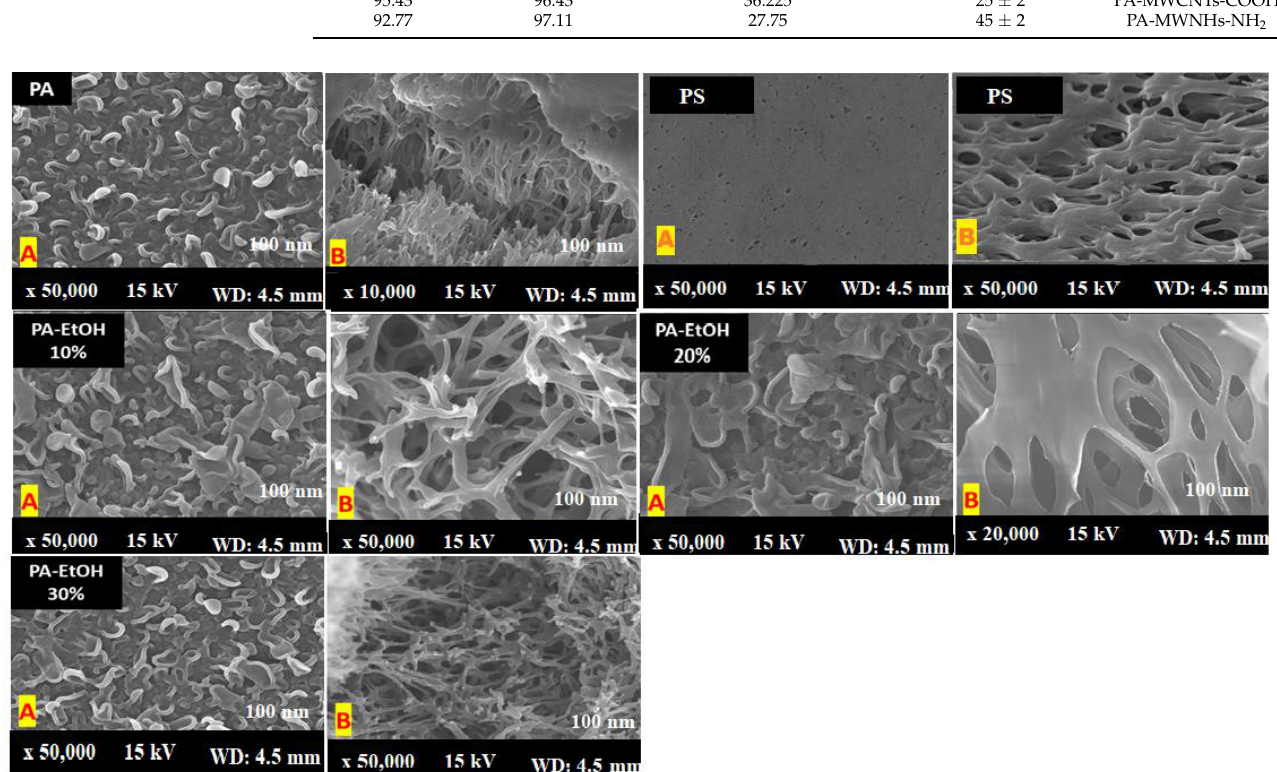
Figure 9. SEM images of the surfaces ( A ) and cross sections ( B ) of PA, PS, PA-EtOH 10%, PA-EtOH 20%, and PA-EtOH 30% membranes.